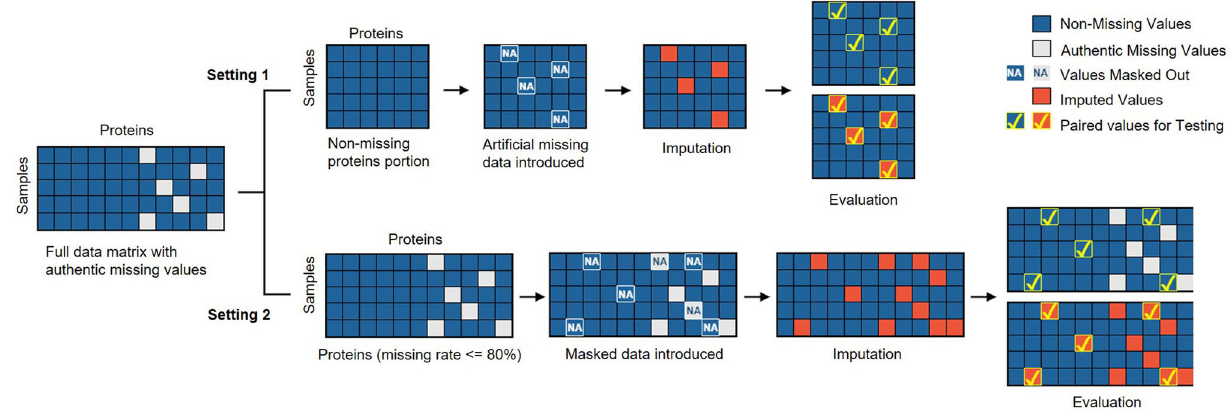
Figure 2. Two-phased workflow of realistic simulation-based assessment on missing value imputation methods.